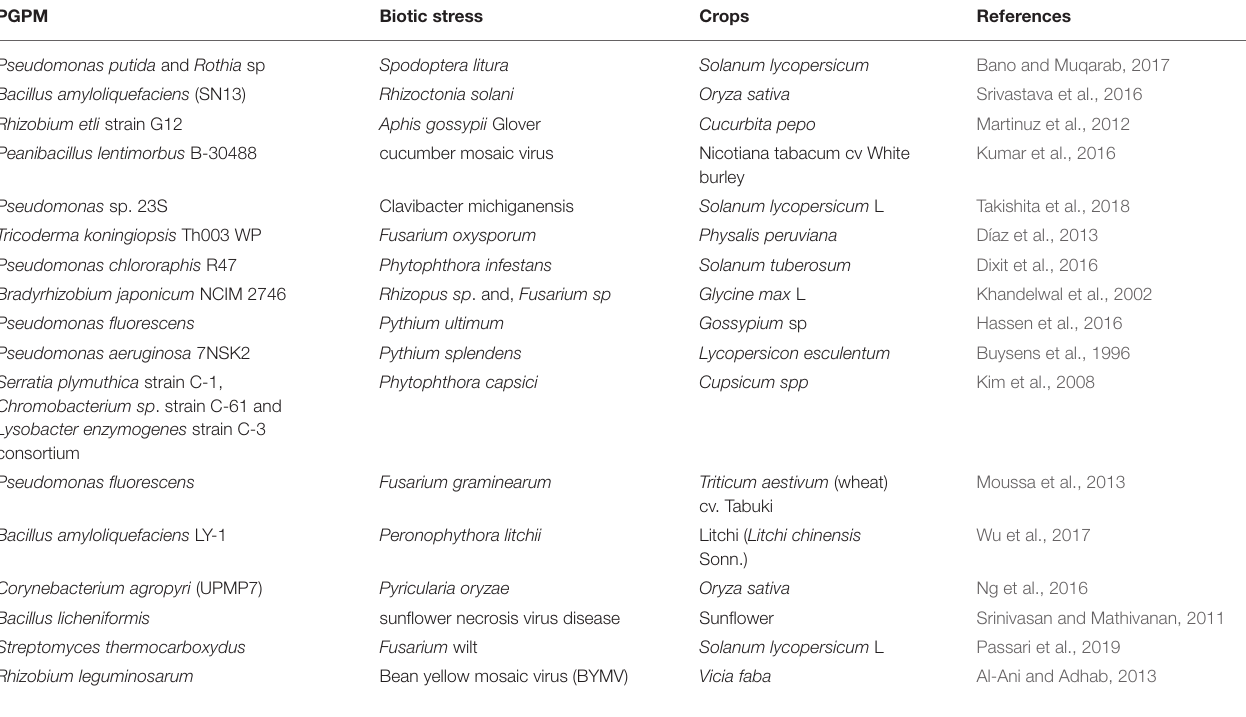
TABLE 2 | PGPR derived crop biotic stress